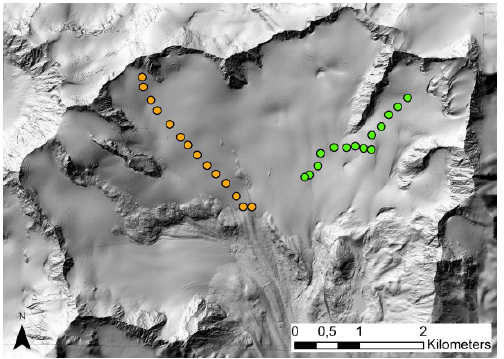
Figure 4. Laser DEM of Vernagtferner with the two profiles near Sexenjoch (orange points) and Hinterer Brochkogel (green points)